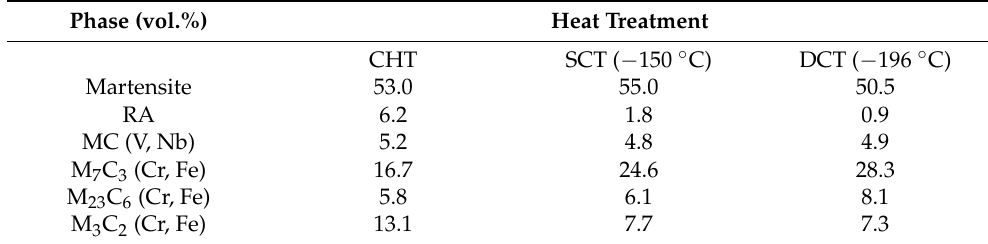
Table 1. Mean volumetric fractions of phases present in the samples; CHT—conventionally heat- treated; SCT—shallow cryogenically heat-treated; DCT—deep cryogenically heat-treated. Phase (vol.%) Heat Treatment CHT SCT ( − 150 ◦ C) DCT ( − 196 ◦ C) Martensite 53.0 55.0 50.5 RA 6.2 1.8 0.9 MC (V, Nb) 5.2 M 7 C 3 (Cr,